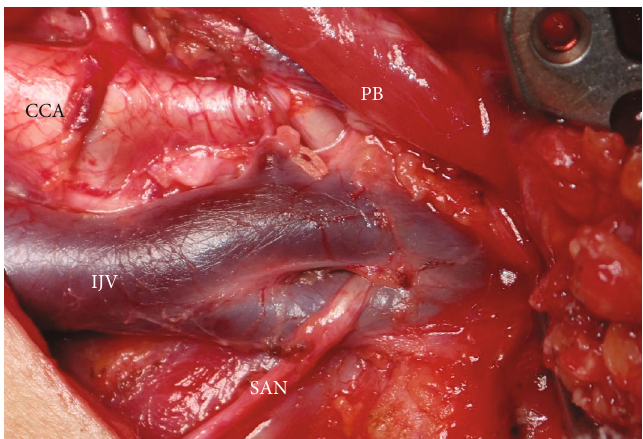
Figure 1: Intraoperative photograph, SAN passes through fenestrated IJV. SAN: spinal accessory nerve; IJV: internal jugular vein; CCA: common carotid artery; PBDM: posterior belly of the digastric